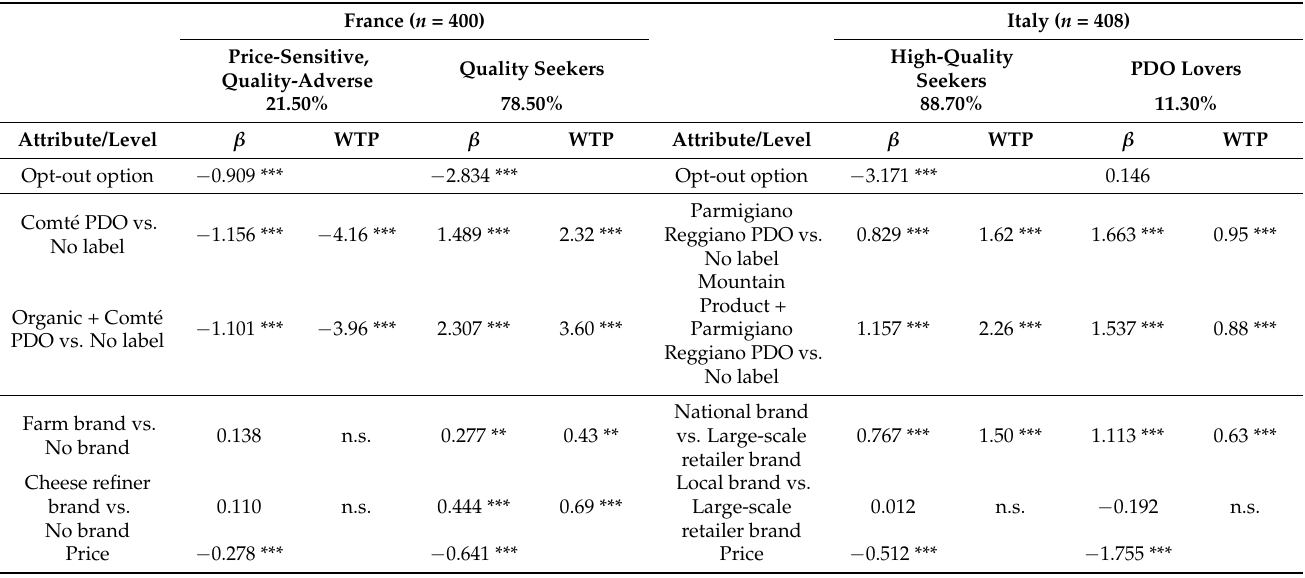
Table 4. Latent class analysis (LCA) models: β -coefficient estimates and willingness to pay (WTP) estimates (expressed in EUR /200 g for France, EUR /300 g in